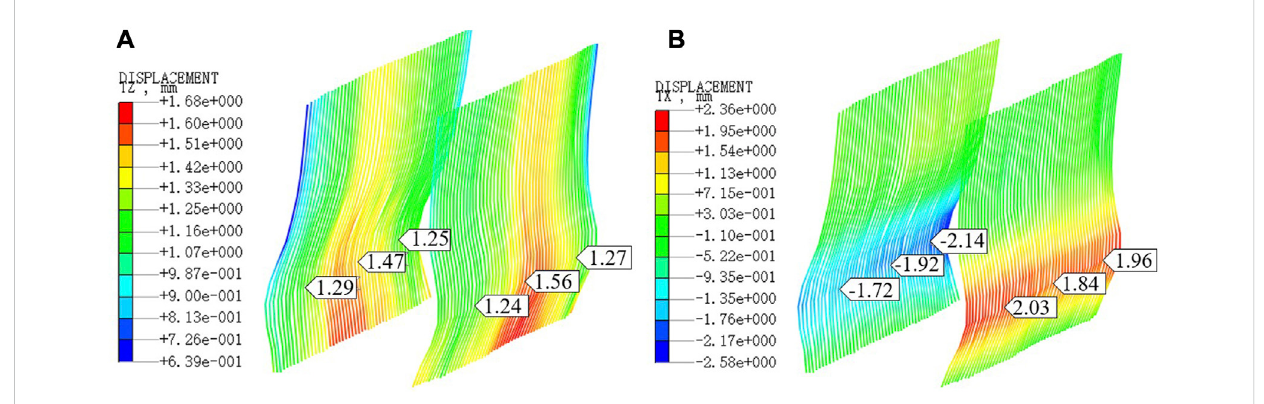
FIGURE 12 Contour diagram of change in the displacement of the isolation pile: (A) vertical displacement of isolation pile, (B) horizontal displacement of isolation